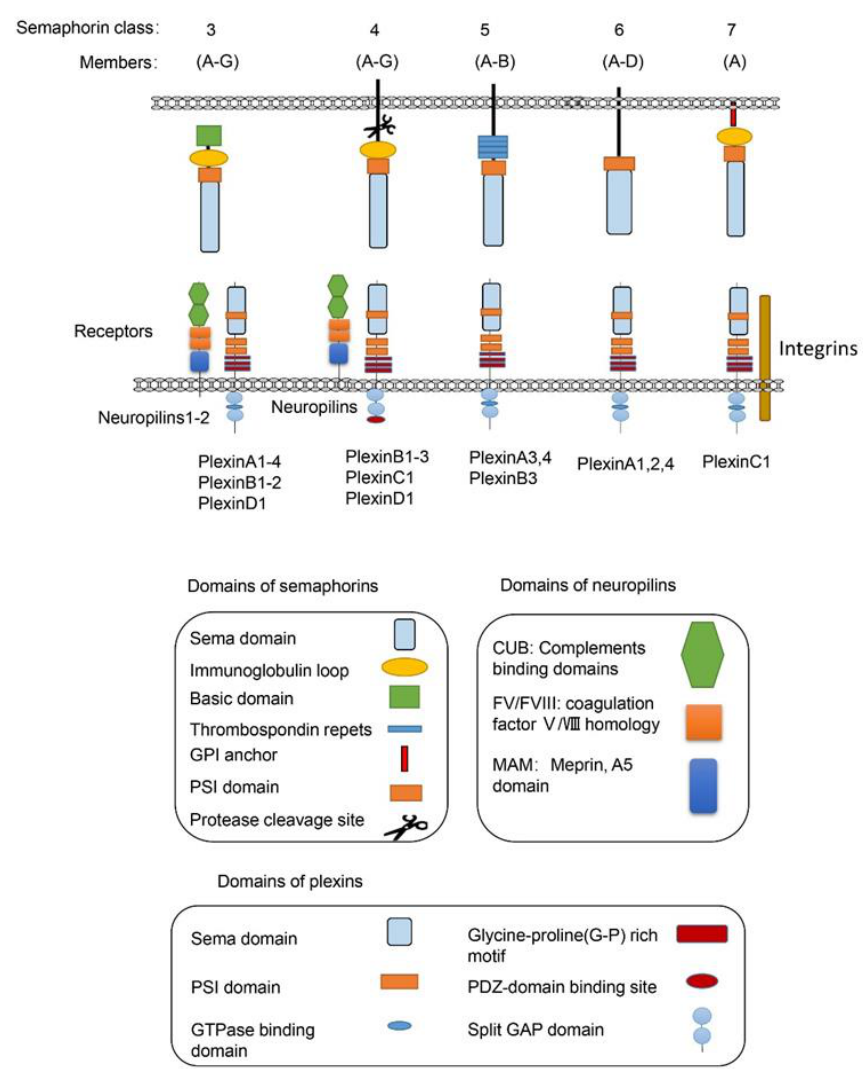
Figure 1. The vertebrate semaphorins and their main receptors. The main structural features of the subfamilies of the vertebrate semaphorins and their receptors are shown. The members of the vertebrate semaphorin family all contain the hallmark Sema domain and are divided into five subfamilies based upon structural features. The Class-3 semaphorins are the only secreted semaphorins. The main receptors for semaphorins are listed below. For most Class-3 semaphorins, neurophilins and plexins are their receptors. For Class-4 semaphorins, the main receptors are PlexinB molecules, while PlexinC1, PlexinD1, and neuropilins can also act as their receptors. For the only member of Sema7, PlexinC1 and integrin β 1 are the main receptors. Many other molecules including integrin, proteoglycans, and RTKs have also been included as receptors for semaphorins, which are not showed in the diagram.